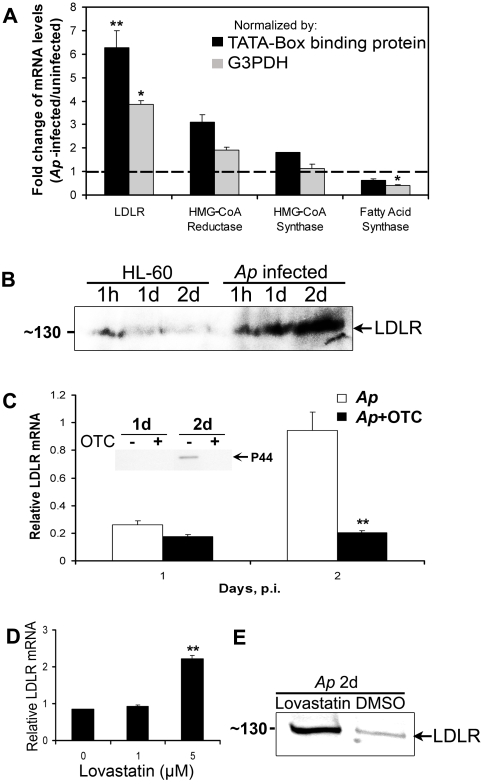
LDLR is up-regulated in A. phagocytophilum–infected HL-60 at transcriptional and protein levels.(A) At day 2 p.i., total RNA was extracted from uninfected and A. phagocytophilum–infected HL-60 cells. Analysis of mRNA amount was performed using quantitative RT-PCR with specific primers for each gene. Transcript levels were normalized to mRNA level of TATA-box binding protein or G3PDH in each sample. Ap, A. phagocytophilum. (B) Cell samples were collected at the indicated time points, membrane fractions were isolated, and western blotting was performed to determine LDLR protein levels in uninfected HL-60 and A. phagocytophilum–infected HL-60 cells. (C) Oxytetracycline (OTC, 10 µg/ml) was added to A. phagocytophilum–infected HL-60 cells at 1 h p.i., RNA was extracted from infected HL-60 cells on days 1 and 2 p.i., and LDLR mRNA was analyzed by quantitative RT-PCR. Transcript levels were normalized to mRNA level of TATA-box binding protein in each sample. Inset shows western blotting result using mAb 5C11 against A. phagocytophilum major surface protein P44. (D) Relative LDLR mRNA in lovastatin-treated cell cultures on day 2 p.i. was analyzed by quantitative RT-PCR with primers specific for LDLR gene. (E) LDLR protein levels in lovastatin- or mock (DMSO)-treated infected cells at day 2 p.i. were analyzed by western blotting using anti-LDLR mAb. Data are expressed as mean±standard deviation (n = 3) and are representative of two independent experiments. *, p<0.05 (unpaired two-tailed t test); **, p<0.01 (unpaired two-tailed t-test).